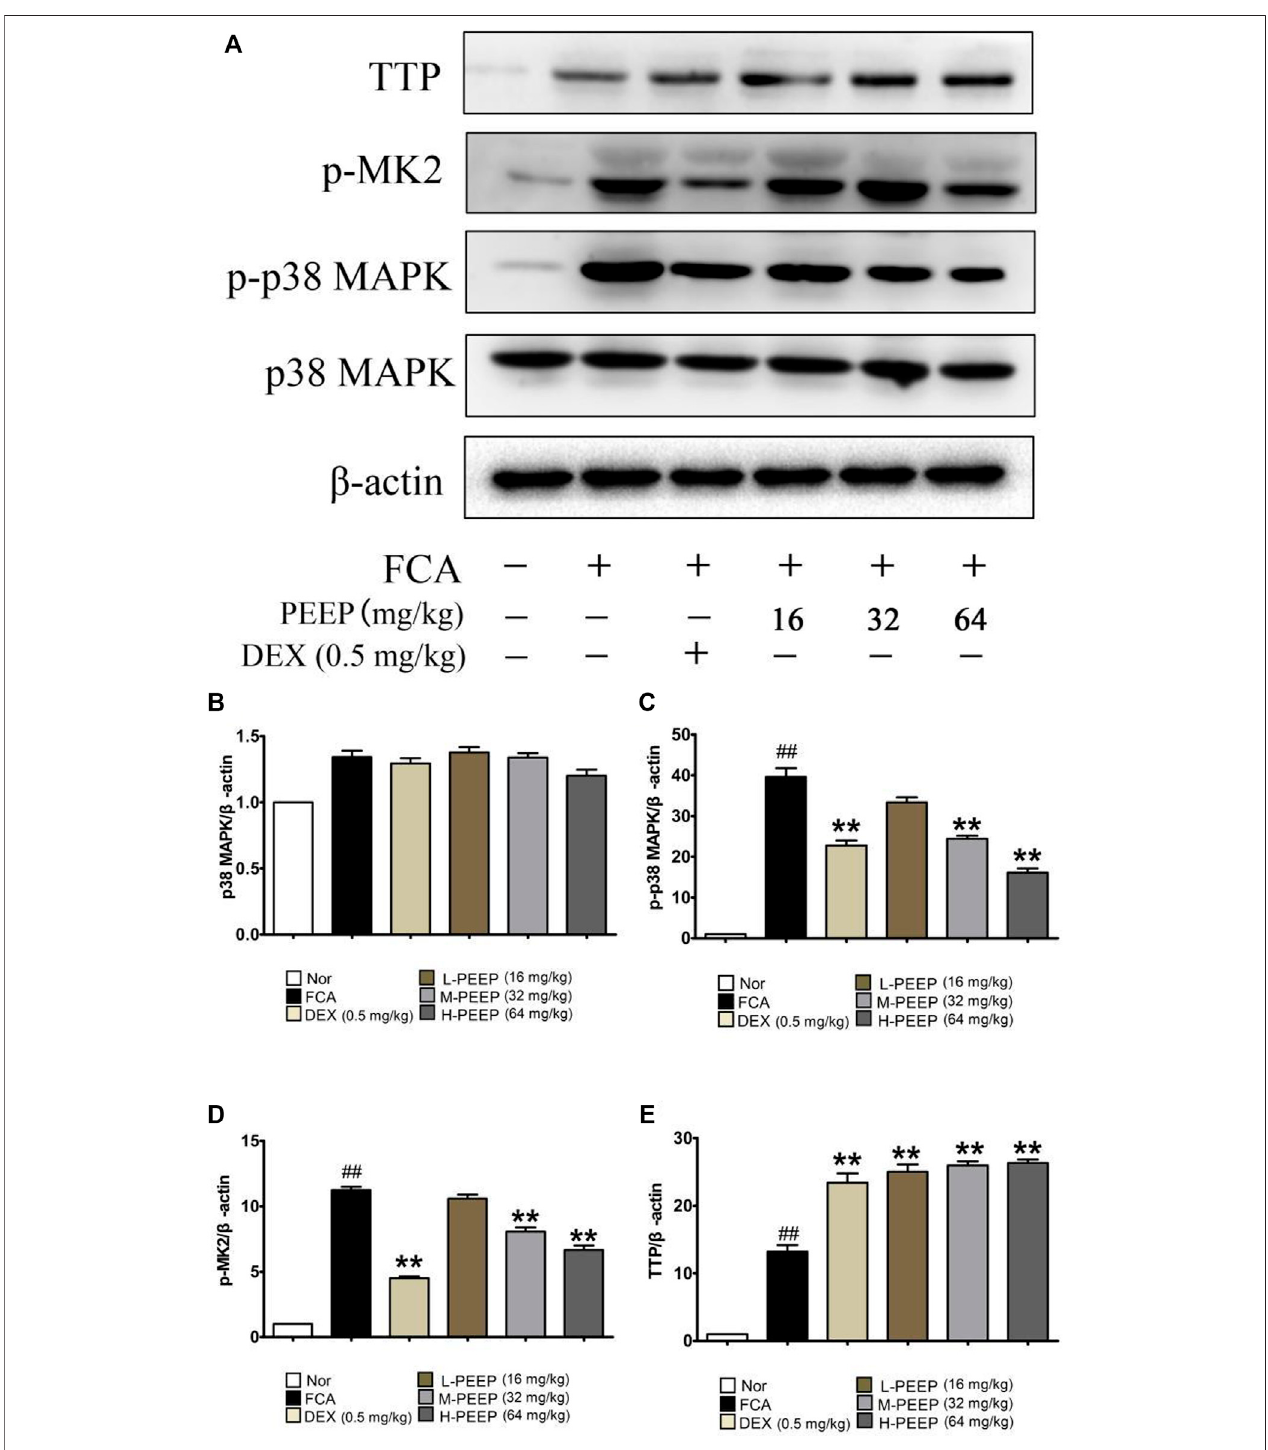
FIGURE9 | Effectsofdifferentdoses of BGEon the p38/MAPK signaling pathway. (A) Theexpression ofp-38, p-p38, p-MK2, and TTPobtained from ankle joints of several groups was detected by western blot analysis. (B) Quantitative analysis of gray value of p38 was performed in several groups with β -actin as loading control. (C) Quantitative analysis of gray value of p-p38 was performed in several groups with β -actin as loading control. (D) Quantitative analysis of gray value of p-MK2 was performed in several groups with β -actin as loading control. (E) Quantitative analysis of gray value of TTP was performed in several groups with β -actin as loading control. Data represent the mean ± S.E.M. of three independent experiments. p < 0.05, ## p < 0.01 vs. Normal group; ** p < 0.01 vs. CFA group.